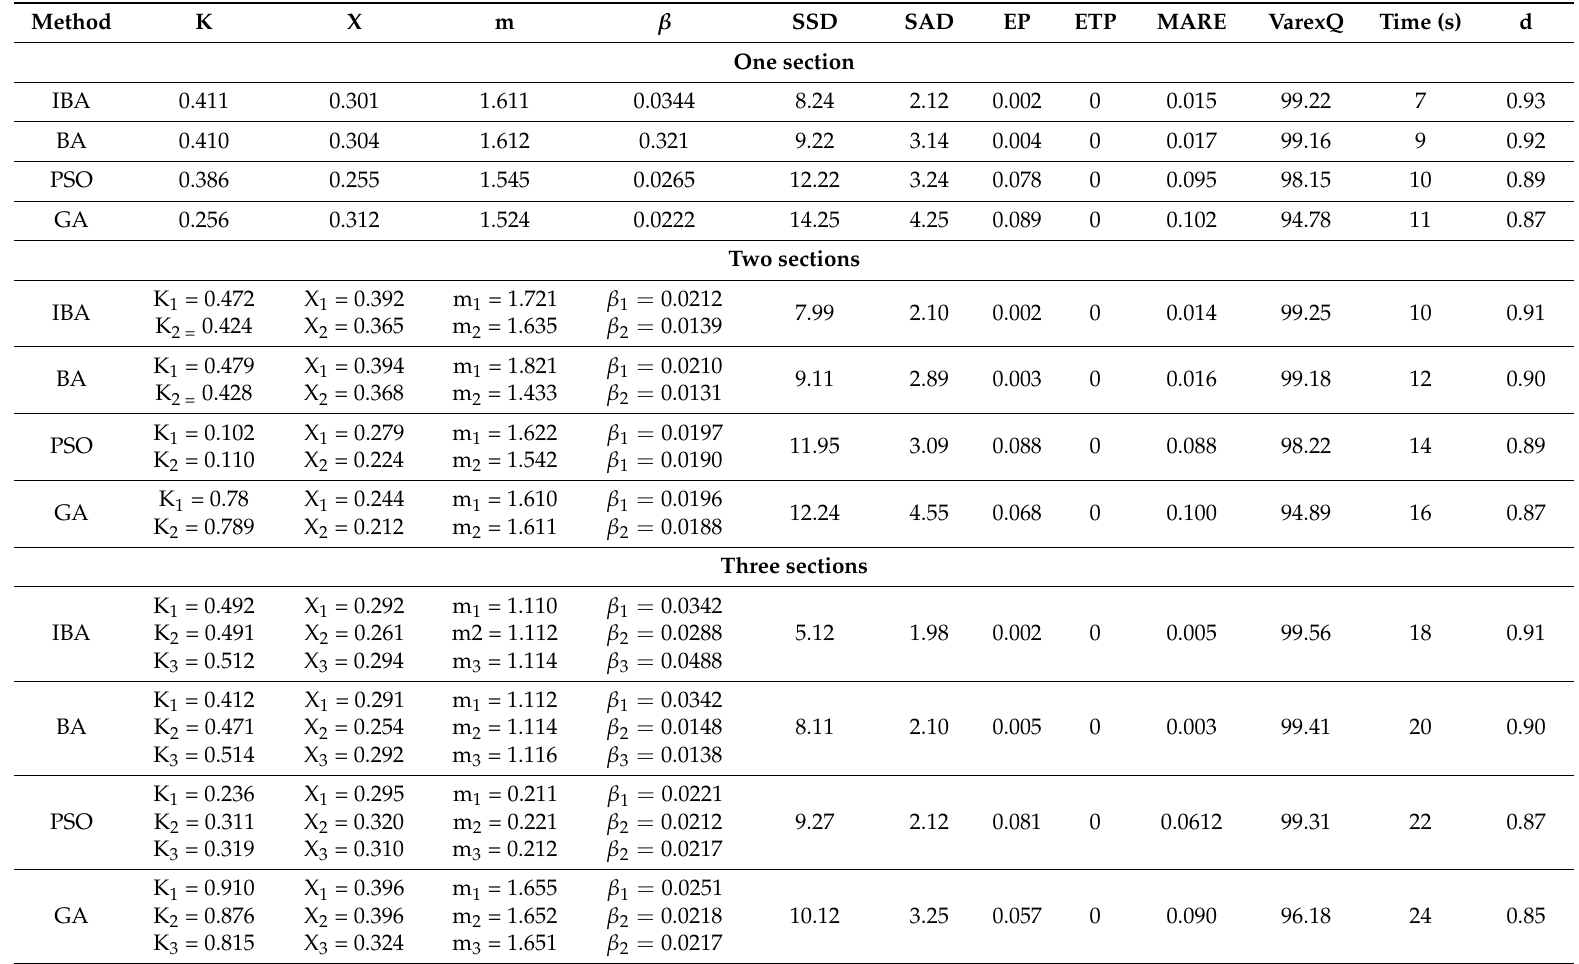
Table 8. The computed error indexes for Myanmar